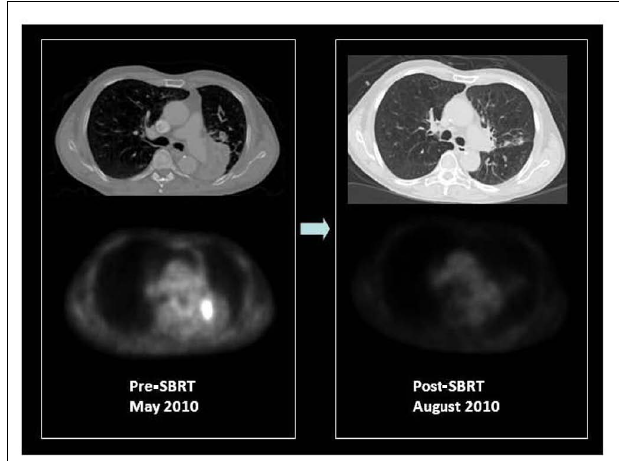
FIGURE 4 | F18 FDG PET/CT of a patient with medically inoperable, centrally located, stage I squamous cell carcinoma of the left lower lobe causing obstructive left lower lung collapse. Contrast CT is unable to differentiate tumor from adjacent collapsed left lower lobe. PET only image of the same axial slice demonstrates FDG avidity of only the tumor and differentiates metabolically active tumor from adjacent collapsed lung. PET was used for stereotactic body radiation therapy image-guided treatment planning to target the FDG avid tumor. Patient received 50 Gy in four fractions in May 2010. Early post-SBRT PET/CT imaging was performed in August 2010 to assess therapy response, which showed a complete metabolic response and re-inflation of the left lower lobe.The patient is currently free of local or distant recurrence or post-radiation complications with improved exercise tolerance and lowered oxygen consumption. Courtesy of UCLA Radiation Oncology SBRT